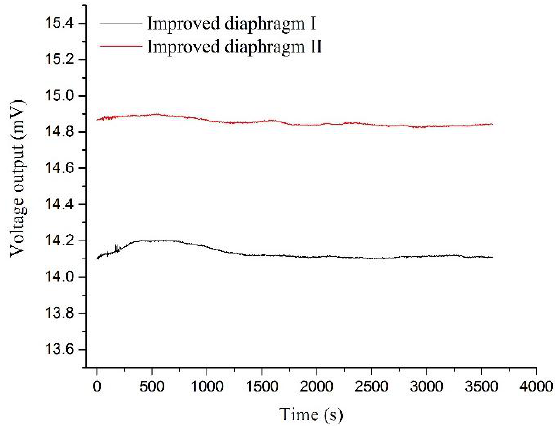
Figure 28. Zero drift data for two proposed sensing chips.